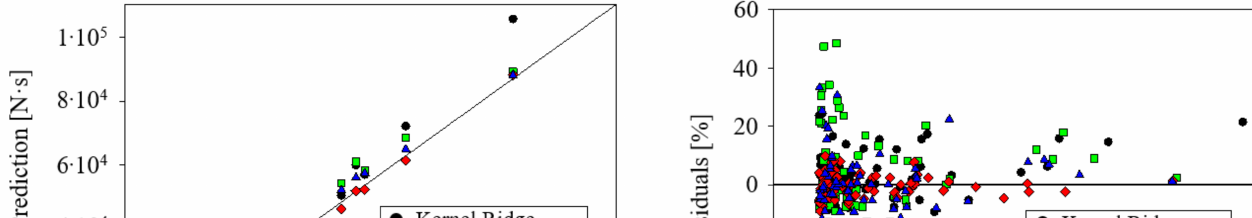
Figure 6. ( a ) True values versus prediction and ( b ) prediction versus residuals for the test data set